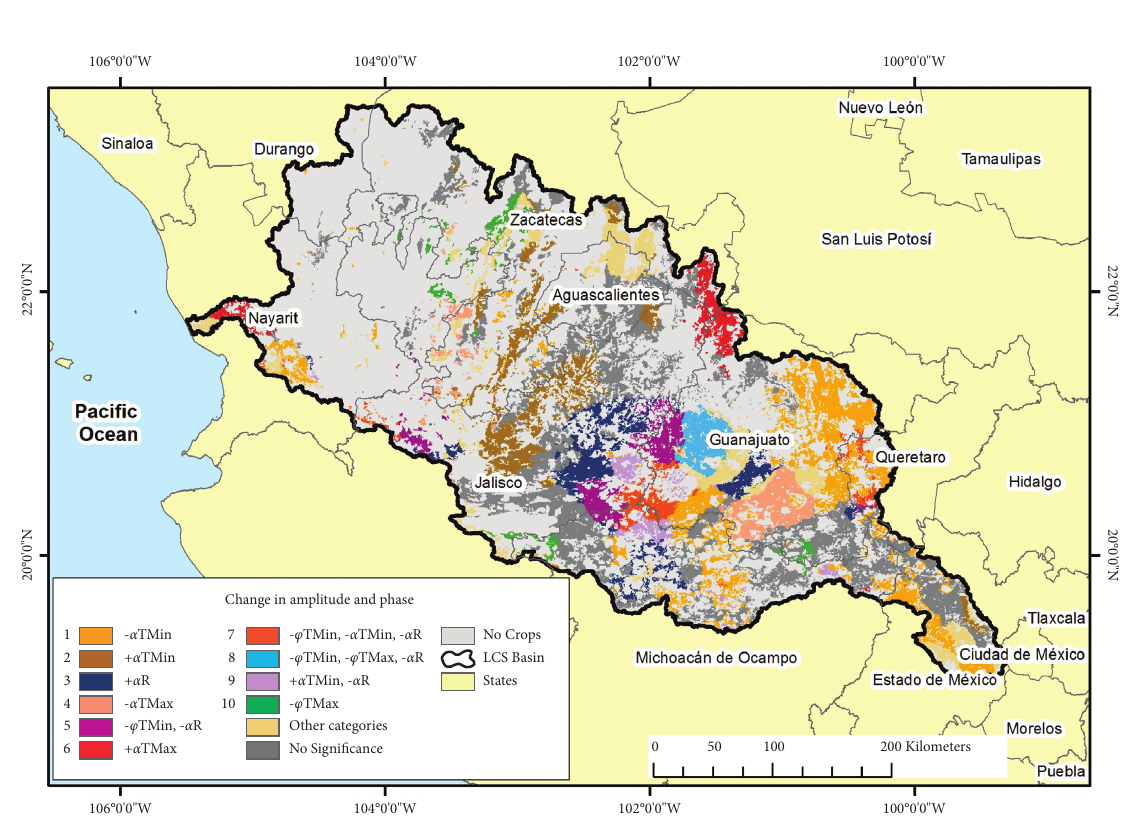
Figure 5: Changes in the amplitude ( α ) and phase ( φ ) of the climate variables in the rainfed crop areas of the LCSB (1960–1985 to